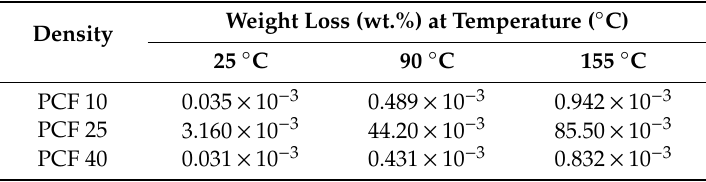
Figure 3. Thermogravimetric analysis (TGA) results of all analysed pure PUR foams. Table 3. Thermal stability results for all analysed PUR foams.